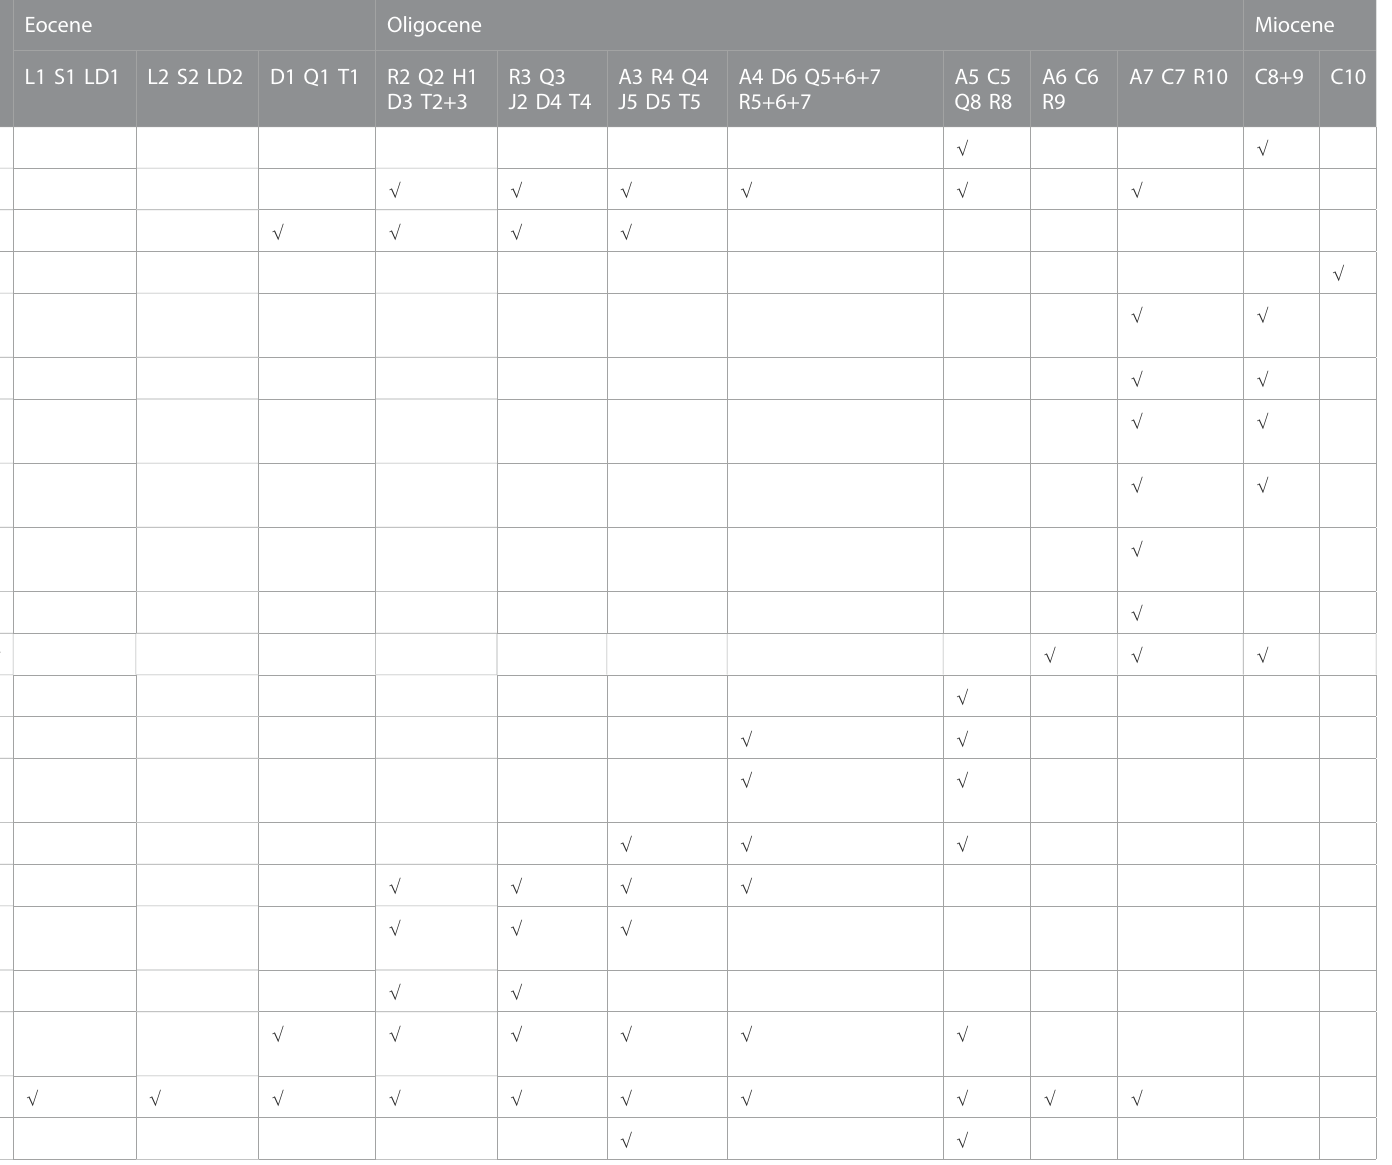
TABLE 1 Stratigraphic levels of selected small mammals identi fi ed from Saint